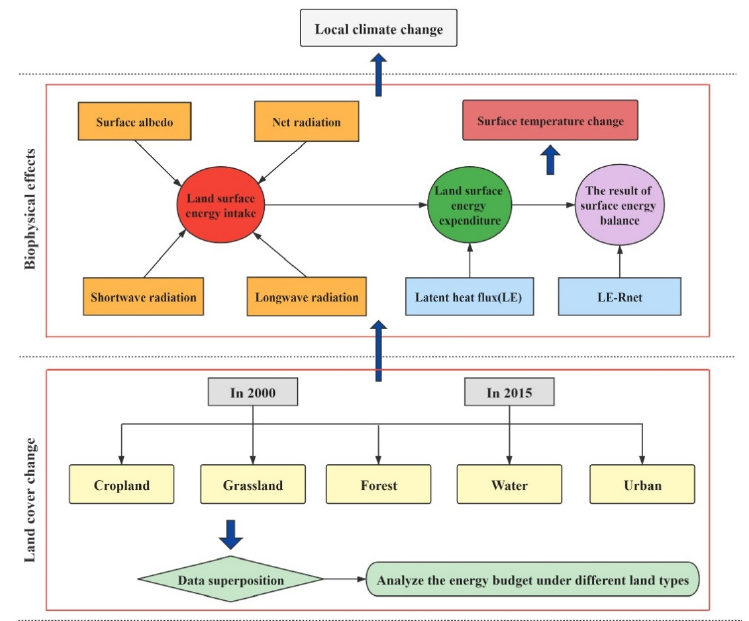
Figure 4. Basic research framework for energy budget feedback of land use